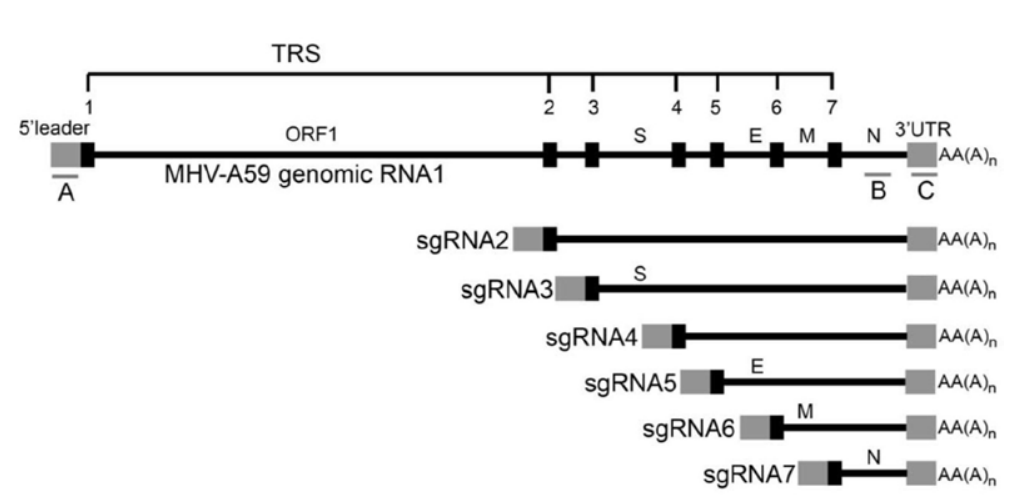
Fig. 7. Subgenomics RNA synthesis of coronavirus Reproduced with permission from